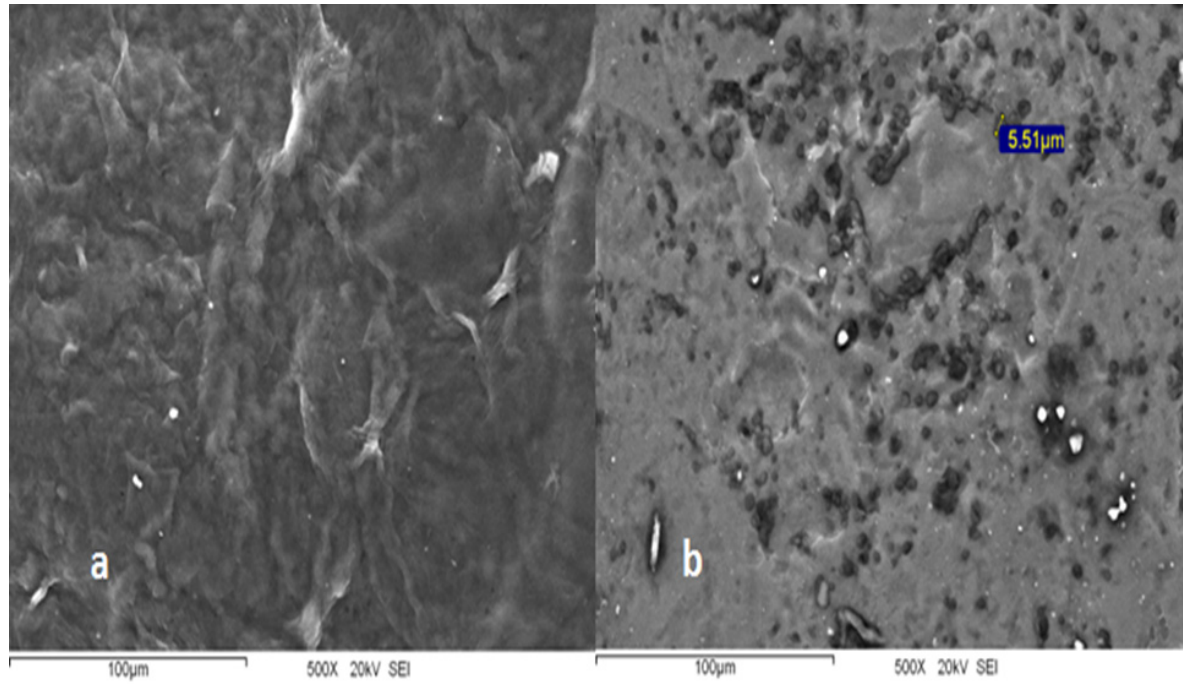
Figure 2. Scanning Electron Microscopy (SEM) pictures of chitosan film ( a ) and chitosan film with 1.5% incorporated carvacrol ( b ) oriented on the dry